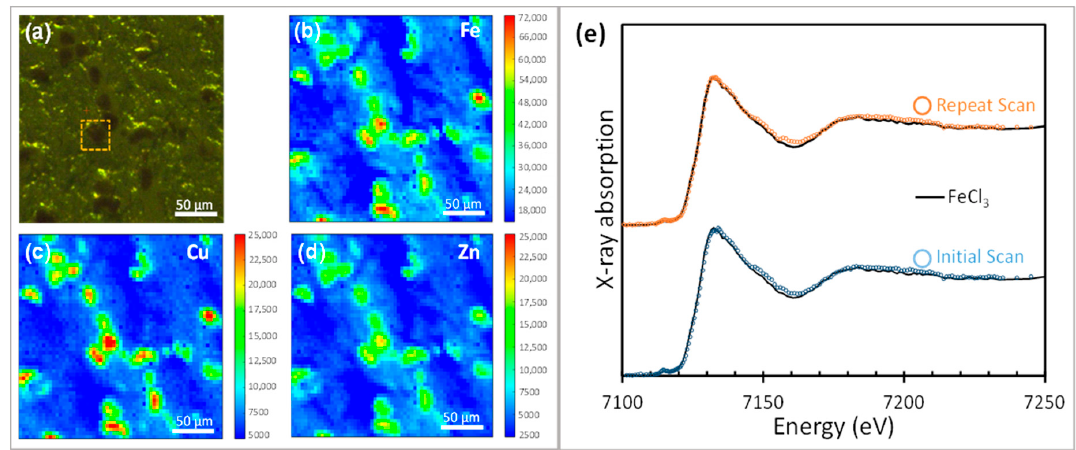
Figure 1. ( a ) Optical image showing melanised dopaminergic neurons in PD substantia nigra tissue. X-ray fluorescence maps of the area shown in ( a ) were collected using a 5 μ m beam and a 0.1 mm Al foil attenuator. XRF maps are shown for ( b ) iron, ( c ) copper, and ( d ) zinc at their respective K-edges. ( e ) Iron XANES from the individual neuron highlighted in ( a ), showing successive scans on the same area to monitor possible photo-reduction, with the results from linear combination fitting of XANES spectra alongside experimental standards (a range of Fe 0 /Fe 2+ /Fe 3+ standards and ferritin-bound Fe 3+ iron). The repeated traces were identical within measurement uncertainty (<2%), and the absorption edge region ( − 20 eV below to +80 eV above the edge) fitted well with 100% FeCl 3 , with χ 2 values of 0.11 and 0.07 obtained for the initial and repeat scans, respectively. Traces were subjected to an edge-step normalization and flattened using Athena fitting software. Traces are vertically offset for clarity.